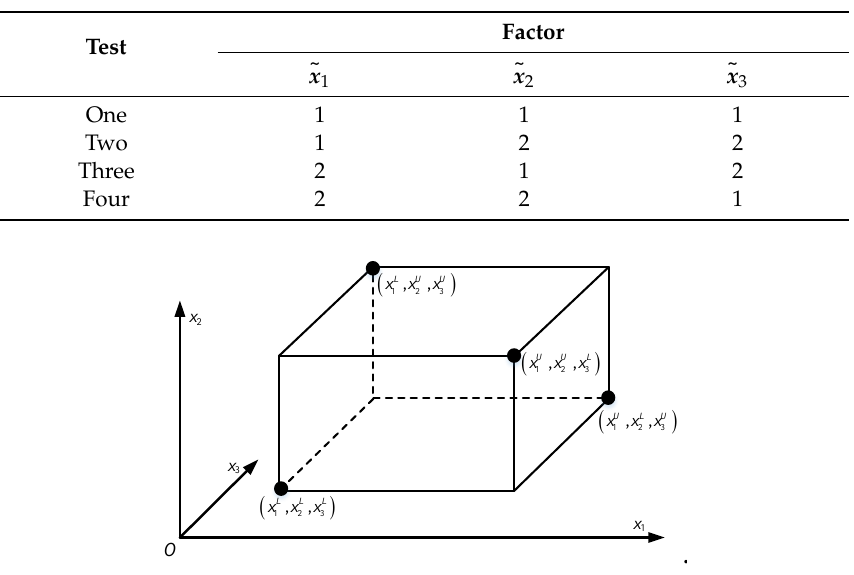
Figure 1. Orthogonal test results of three-dimensional interval numbers.